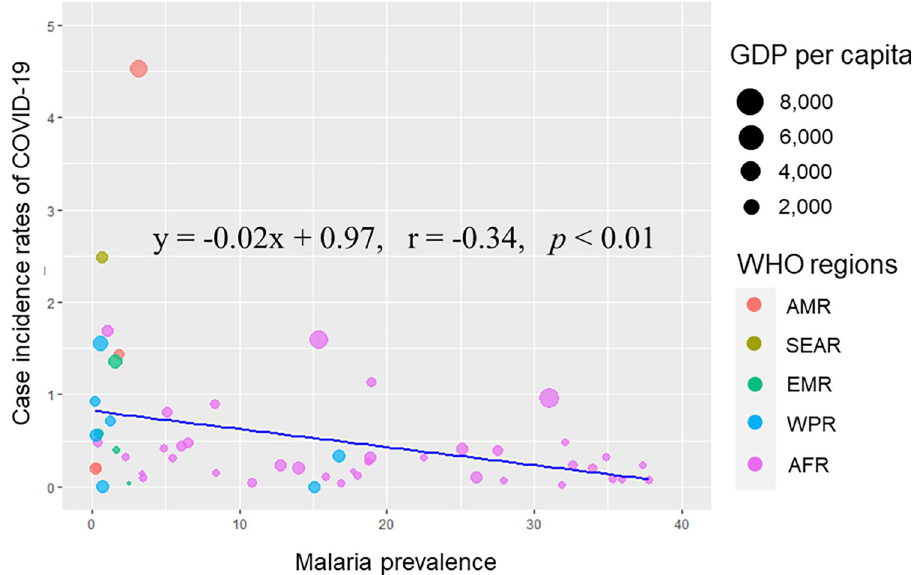
Fig 3. Scatter plot diagram of the malaria prevalence and case incidence rates of COVID-19 for malaria-endemic countries.